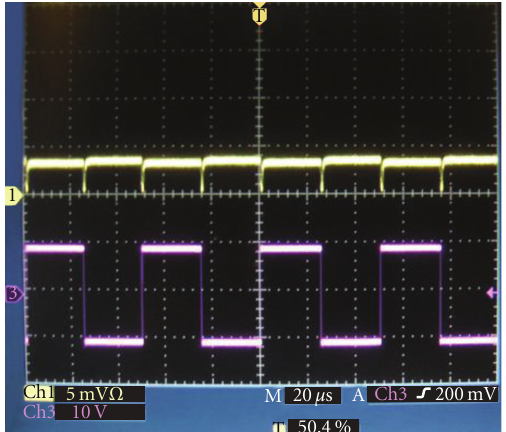
Figure 4: 1.5- μ m optical output signal after polarizer with the angular di ff erence between transmitter and receiver of | Δ θ | = 45 ◦ . (a) The 1.5- μ m optical output signal after the polarizer and (b) the applied voltage (20: 1) for the polarization modulator are shown as Ch1 and Ch3 with the modulated frequency of